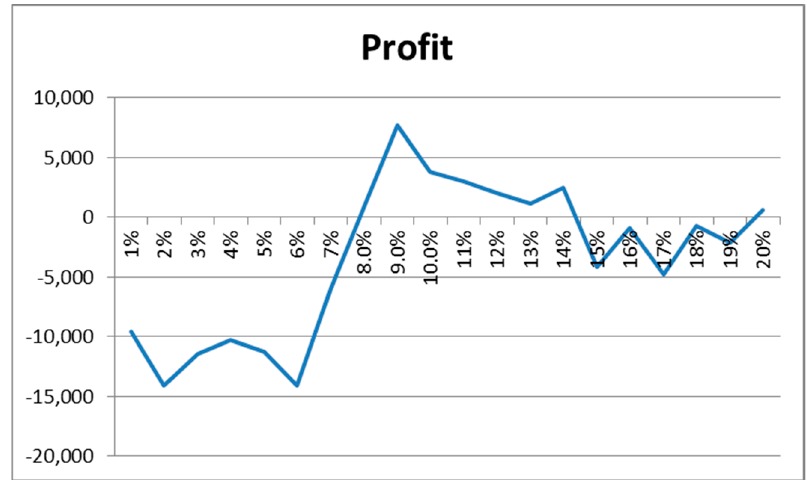
Figure 9. Default Output Limit Exit Strategy. Source: Authors’ processing is based on data available on http://stooq.com/ (accessed on 20.07.2017).